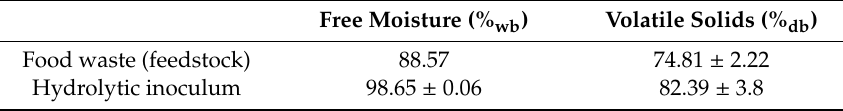
Table 3. Moisture and volatile solids content in feedstock and